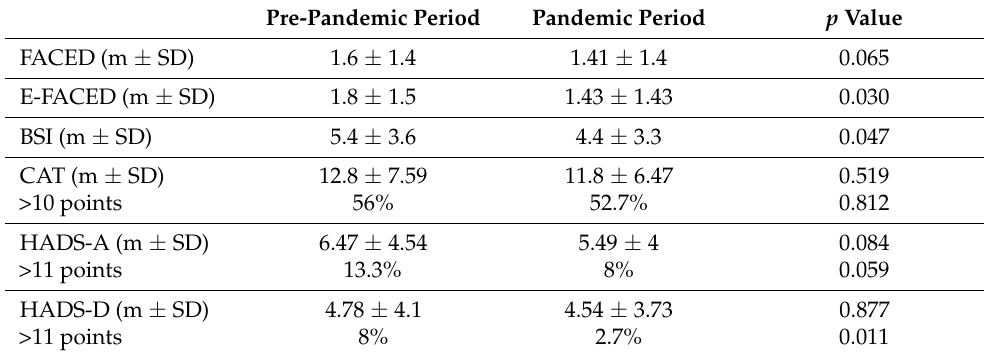
Figure 5. Mean score of the BSI scale in the pre-pandemic and pandemic periods. The yellow dots represent the mean of the BSI in the pre-pandemic (red) and pandemic (blue) periods. Table 4. Comparison of the FACED, E-FACED, and BSI scales and the CAT and HADS questionnaires during the pre-pandemic and pandemic periods.